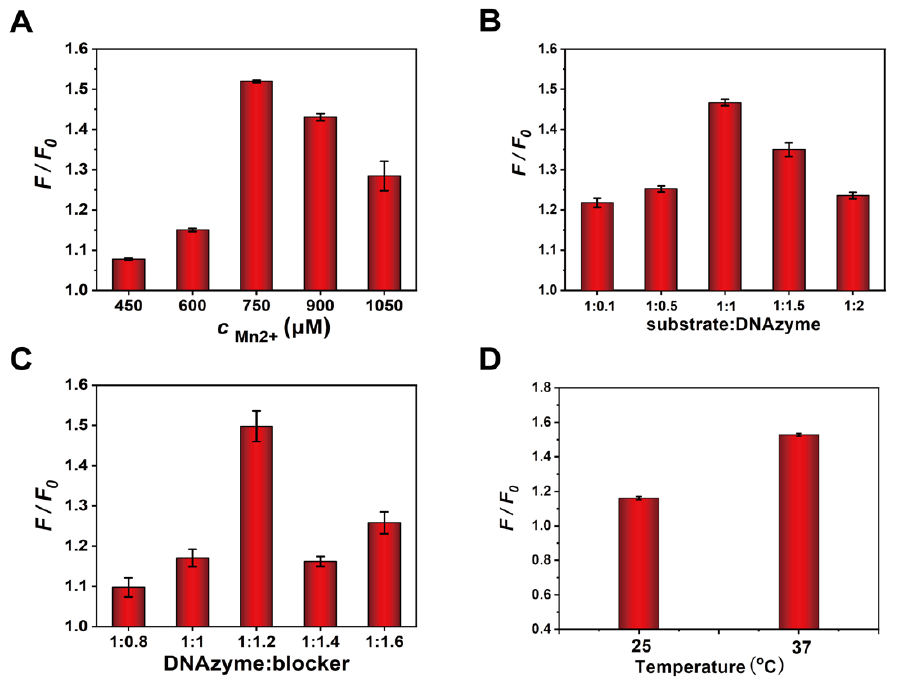
Figure 3. Optimization of experimental conditions for DNAzyme amplifier performance. ( A ) Optimization of the ratio between the DNAzyme and blocker. ( B ) Optimization of the ratio between the substrate and DNAzyme. ( C ) Optimization of the Mn 2+ concentration. ( D ) Optimization of temperature in miR-10b detection. Error bars represented the standard deviation of three determinations. Experimental conditions: substrate concentration of 25 nM, DNAzyme concentration of 25 nM, blocker concentration of 30 nM, Mn 2+ concentration of 750 μM, 25 mM Tris-HCl buffer (containing 137 mM NaCl, pH 7.0).